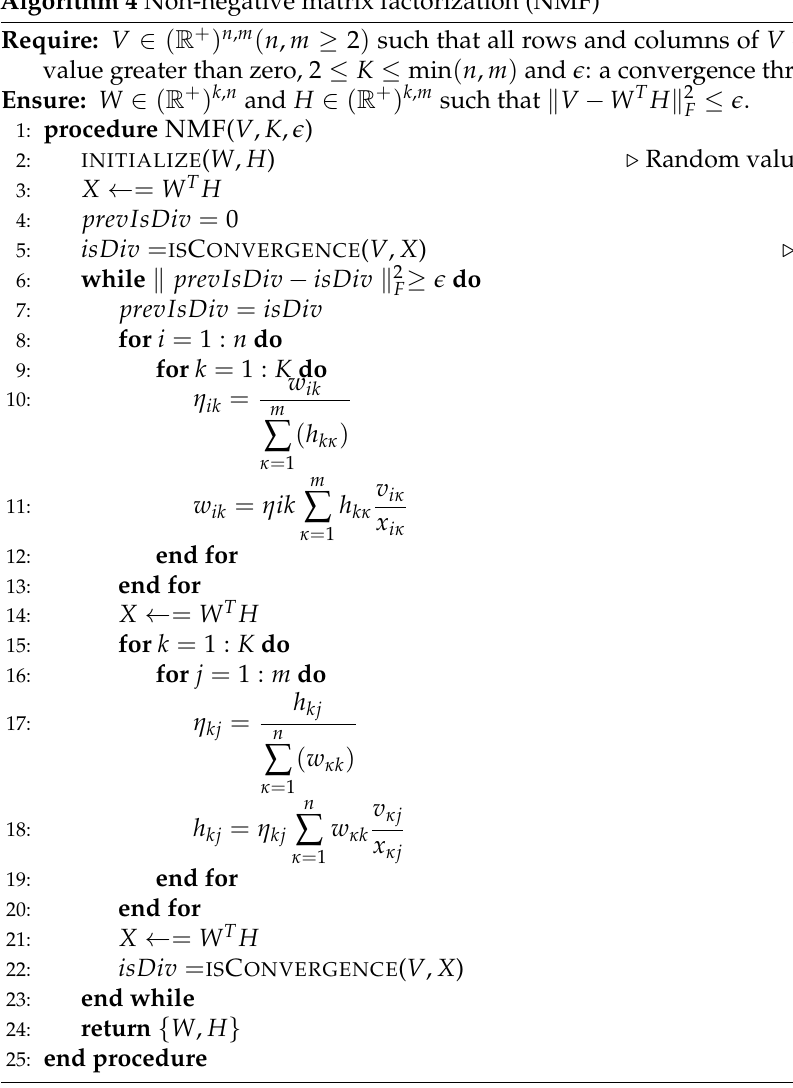
Algorithm 4 Non-negative matrix factorization (NMF)